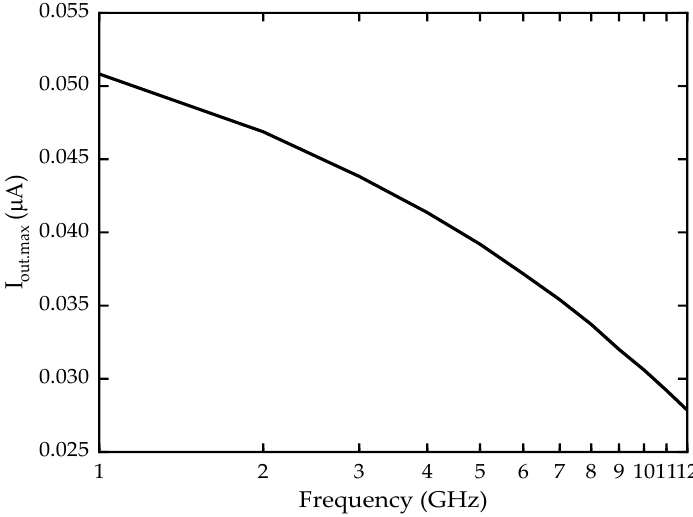
Figure 10. Maximum output current I out.max in various frequencies.